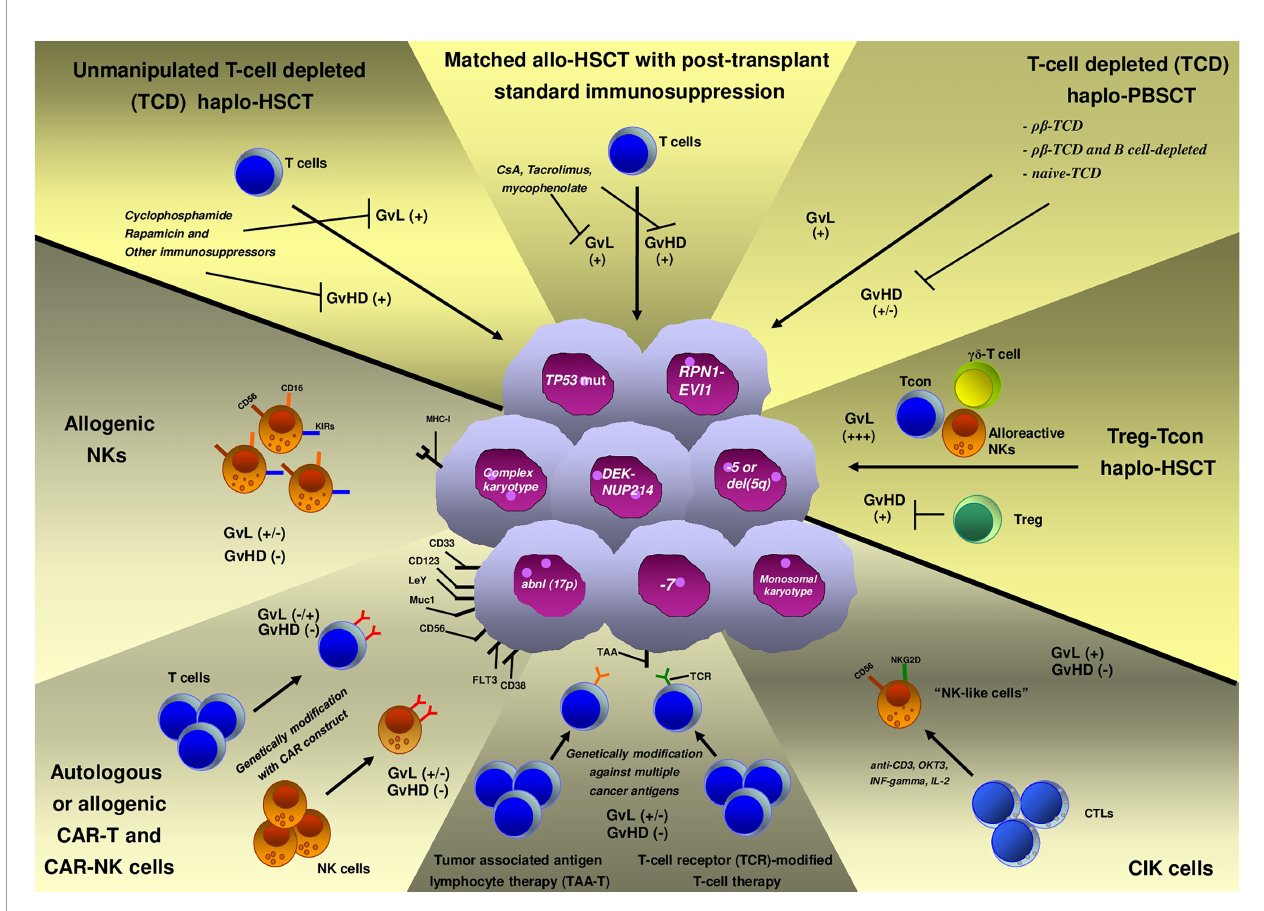
FIGURE 1 | Available immune cell-based therapies for high-risk acute myeloid leukemia